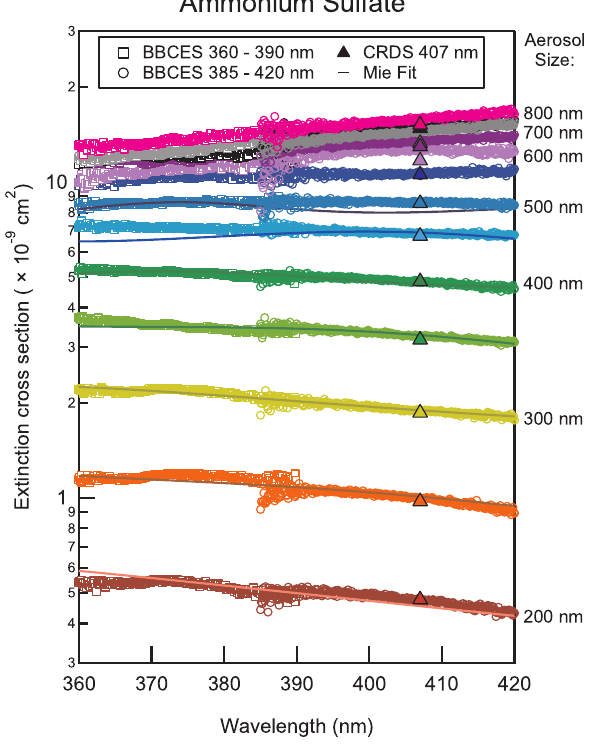
Fig. 5. Extinction cross sections as a function of wavelength for ammonium sulfate aerosol at 200–800nm diameter measured with the BBCES 360–390nm, BBCES 385–420nm, and CRDS at λ = 407nm. The solid lines show the best Mie fit. The extinction cross sections shown in this plot have been corrected for doubly and triply charged particles, using an assumed refractive index of m = 1 . 52 + 0 i